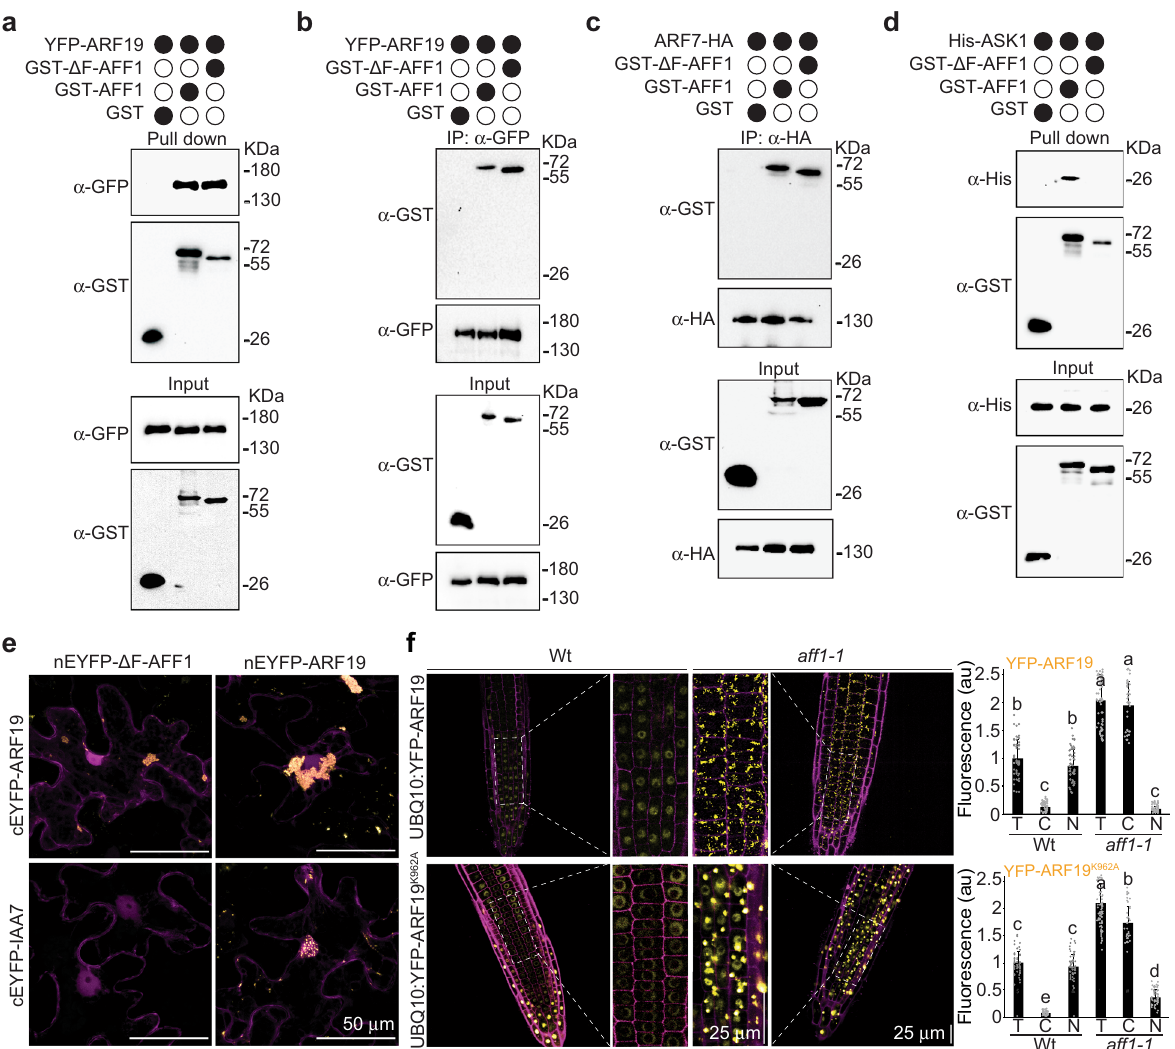
Fig. 5 AFF1 interacts with ARF proteins and ASK1. a GST, GST-AFF1 or GST- Δ F-box-AFF1 recombinant proteins were incubated with arf19-1 35 S:YFP- ARF19 plant lysate. Pull-down fractions and inputs were examined by immunoblot analysis using anti-GFP or anti-GST antibodies. b GST, GST-AFF1 or GST- Δ F-box-AFF1 were incubated with arf19-1 35 S:YFP-ARF19 plant lysate prior to immunoprecipitation with anti-GFP antibody. Immunoprecipitates and inputs were examined by immunoblot analysis using anti-GFP or anti-GST antibodies. c GST, GST-AFF1 or GST- Δ F-box-AFF1 were incubated with 35 S:ARF7-HA plant lysate prior to immunoprecipitation with anti-HA antibody. Immunoprecipitates and inputs were examined by immunoblot analysis using anti-HA or anti-GST antibodies. d GST, GST-AFF1 or GST- Δ F-box-AFF1 were incubated with His-ASK1 prior to pull down. Pull-down fractions and inputs were examined by immunoblot analysis using anti-His or anti-GST antibodies. e Bimolecular fl uorescence complementation (BiFC; yellow) assays were used to analyze protein interactions between nEYFP- Δ F-box-AFF1 and cEYFP-ARF19, nEYFP- Δ F-box-AFF1 and cEYFP-IAA7, nEYFP-ARF19 and cEYFP-ARF19, or nEYFP-ARF19 and cEYFP-IAA7. The nuclear marker WPP-mCherry (magenta) was co-expressed to determine nuclear signal. Scale bar = 50 µ m. See Supplementary Fig. 3 for extended data. f Left, confocal images of 3d-old wild type (Wt; Col-0) or aff1-1 seedlings carrying UBQ10:YFP-ARF19 or UBQ10:YFP- ARF19 K962A (false-colored yellow) with cell walls counterstained with propidium iodide (false-colored magenta). Scale bar = 25 µ m. Right, quanti fi cation of subcellular fl uorescence. T (total), C (cytoplasmic), and N (nuclear). See Supplementary Fig. 4 for images from additional regions of the root. Three independent experiments were performed on ( a ), ( b ), ( c ), ( d ), ( e ) and ( f ) with similar results. n = 56 ( ARF19 ) and n = 54 ( ARF19 K962A ) independent cells were examined in (f). Data in (f) are mean ± SD and gray dots represent the individual values. Different letters indicate individual groups for multiple comparisons with signi fi cant differences (one-way ANOVA, Duncan, p < 0.05). The source data in ( a ), ( b ), ( c ), ( d ) and ( f ) are provided as a Source Data fi